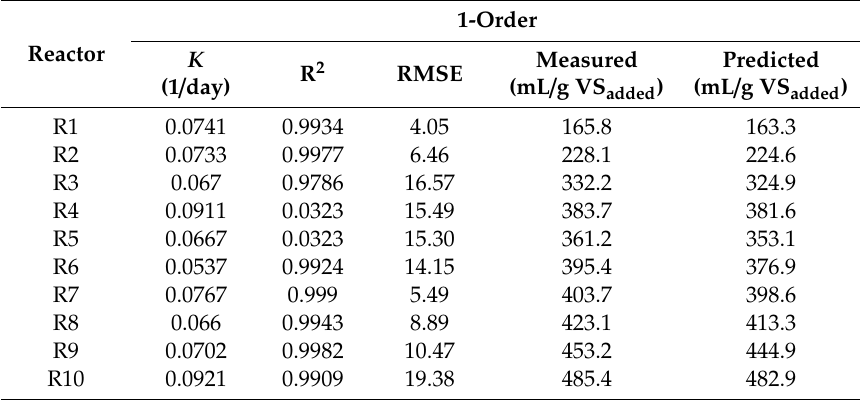
Table 6. Results from the 1-order